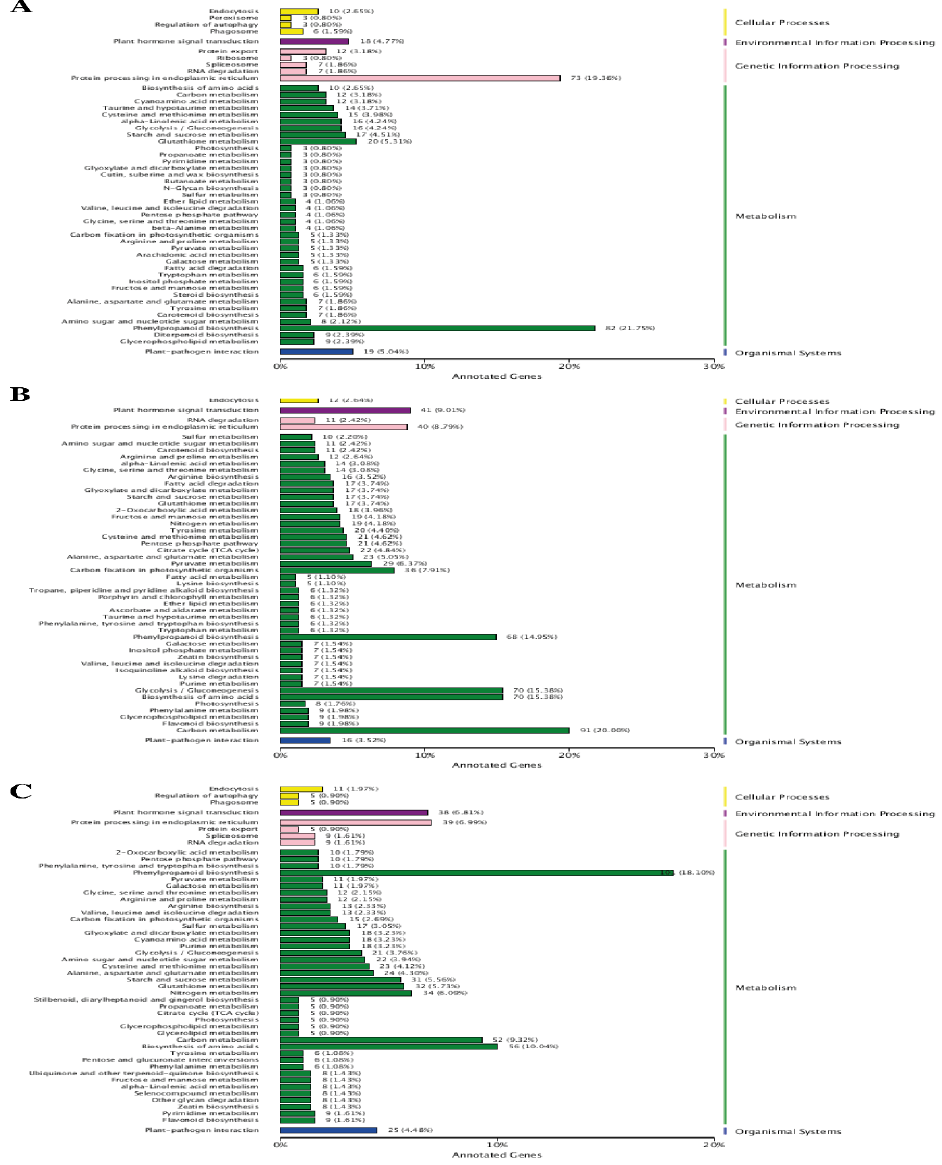
Figure 6. KEGG pathway annotation of DEGs at three comparative stages under Cd stress. ( A ) At 7d of Cd stress; ( B ) at 14d of Cd stress and ( C ) at 30d of Cd stress.